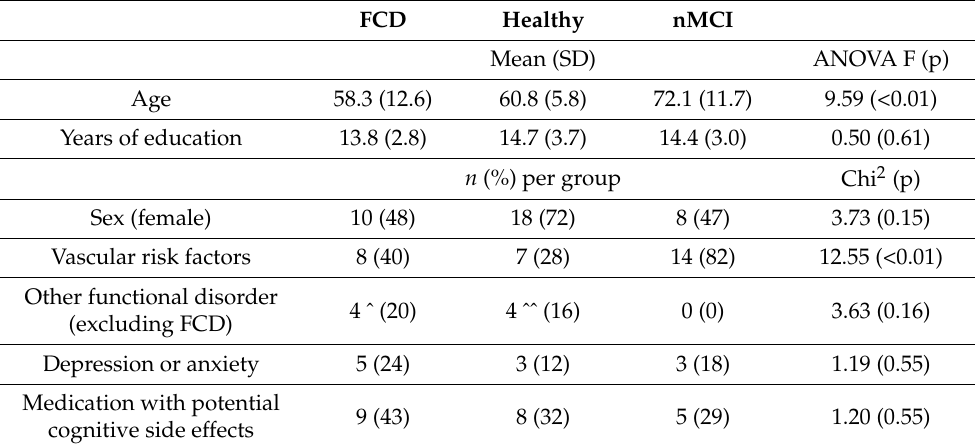
Table 1. Demographics, comorbidities and current medication use per